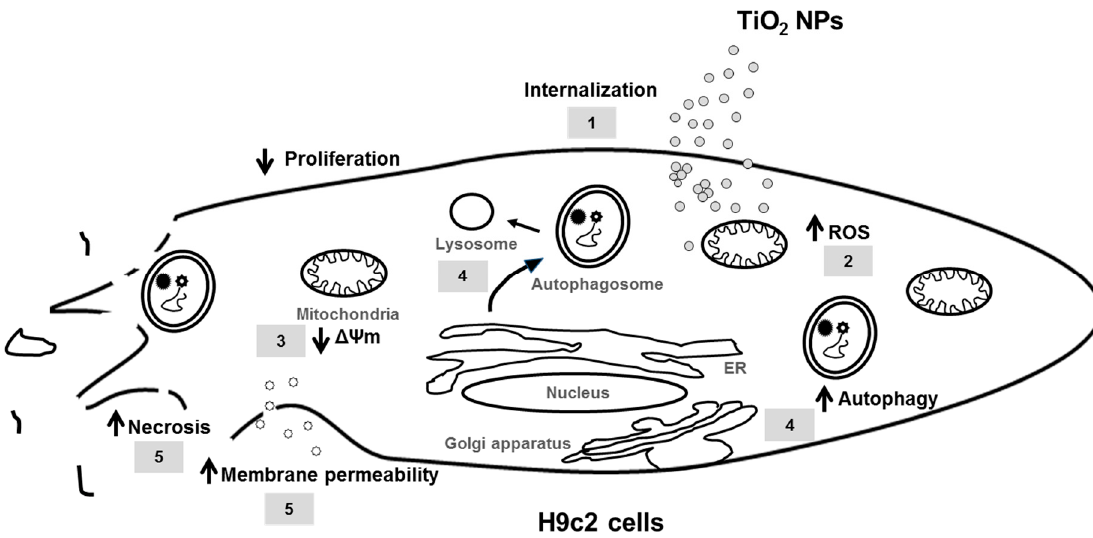
Figure 9. Toxic effects induced by TiO 2 NPs in H9c2 cells. TiO 2 NPs are internalized into the cytoplasm (1), producing strong oxidative stress and changes in the cellular redox state, increasing ROS production and mitochondrial damage (2), decreasing mitochondrial membrane potential ( ∆Ψ m) (3). High oxidative stress causes strong cell damage, associated with autophagy (4), involving the formation of autophagosomes in the endoplasmic reticulum (ER), these in turn fuse with lysosomes to produce degradation of cytoplasmic components formed during cell damage. Finally, TiO 2 NPs increase membrane permeability and induce necrosis (5).